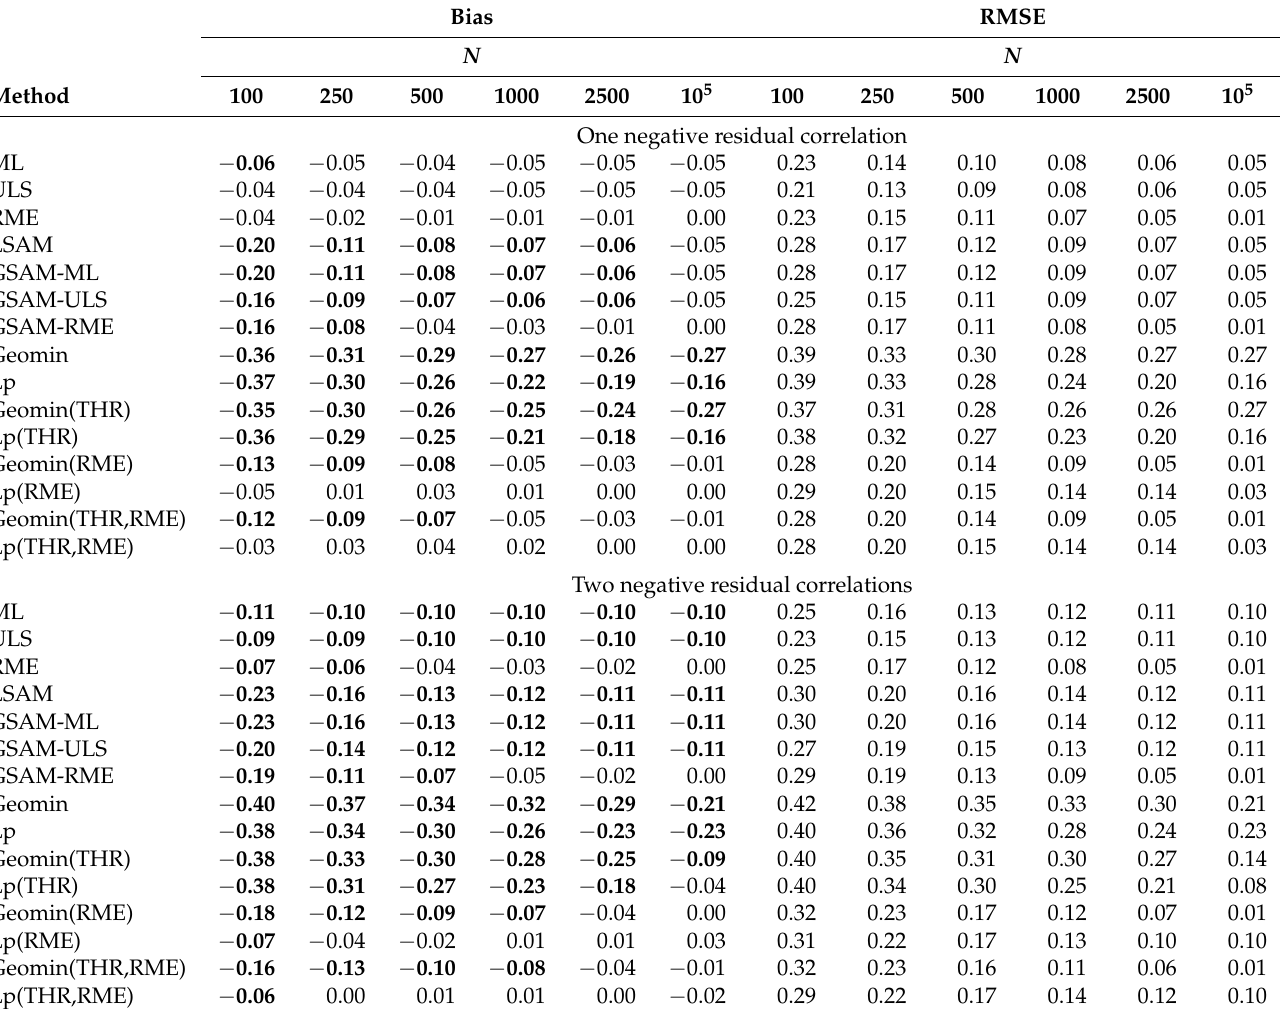
Table A1. Simulation Study 1 (two factors and residual correlations): bias and root mean square error (RMSE) of estimated factor correlation as a function of sample size with one negative and two negative residual correlations in the data-generating